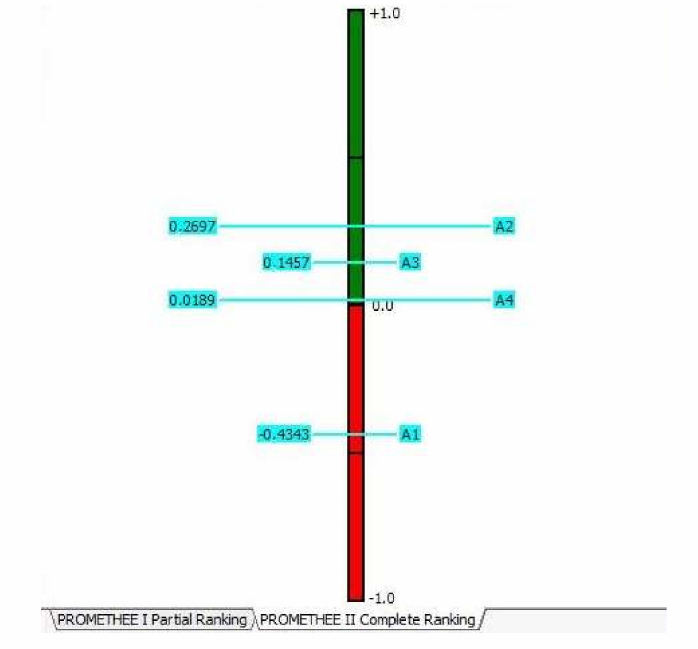
Figure 10. Complete ranking of alternatives based on the PROMETHEE II method, taking into consideration all categories of possible decisions (Asvestades